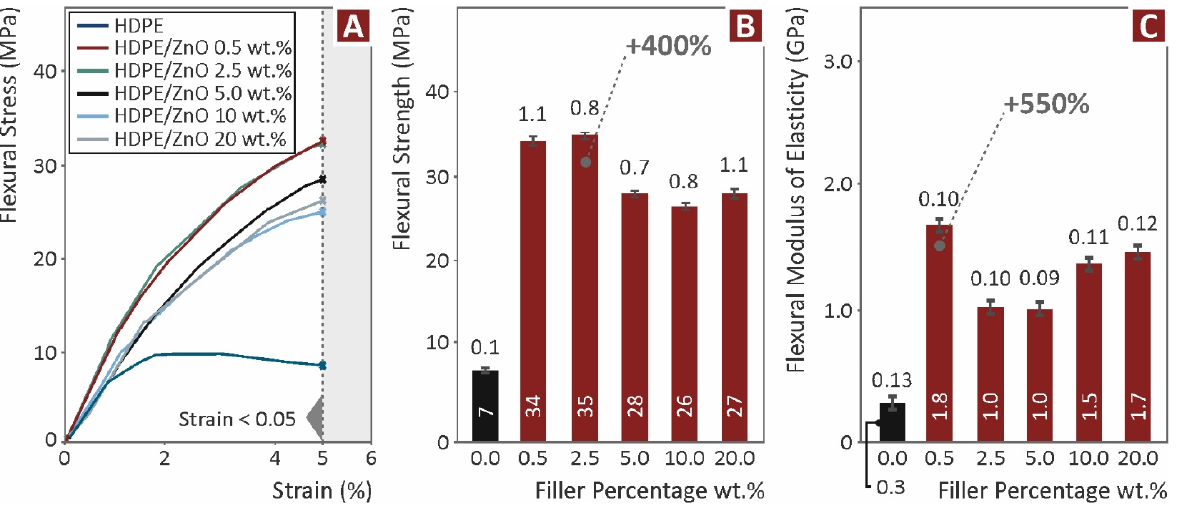
Figure 3. ( A ) Flexural stress compared to strain curves experimentally determined for the unfilled HDPE and the HDPE/ZnO composites, ( B ) Comparative average flexural strength graph (average value is depicted inside the bars) and deviation (value is depicted on top of the bars), and ( C ) Average experimentally calculated flexural mod. of elasticity values and their deviation for the materials of this work.